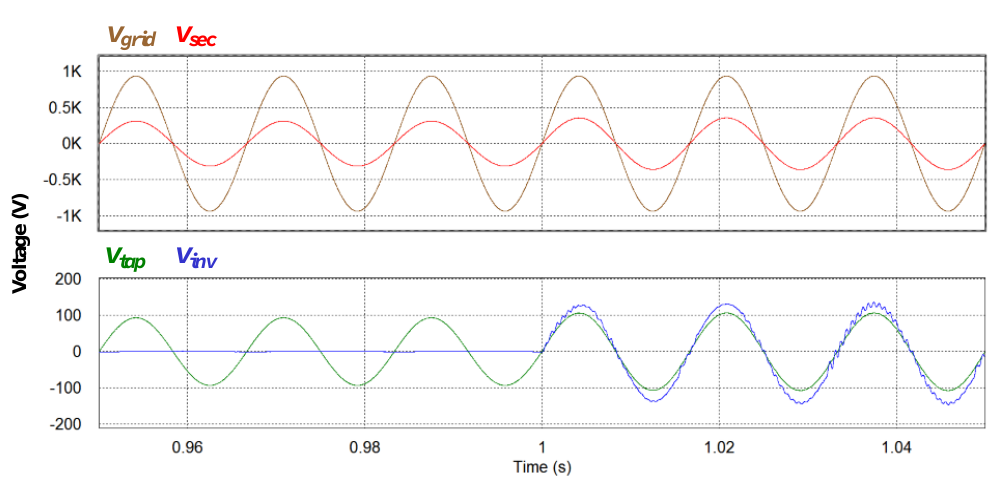
Figure 9. Simulation results of buck mode operation.